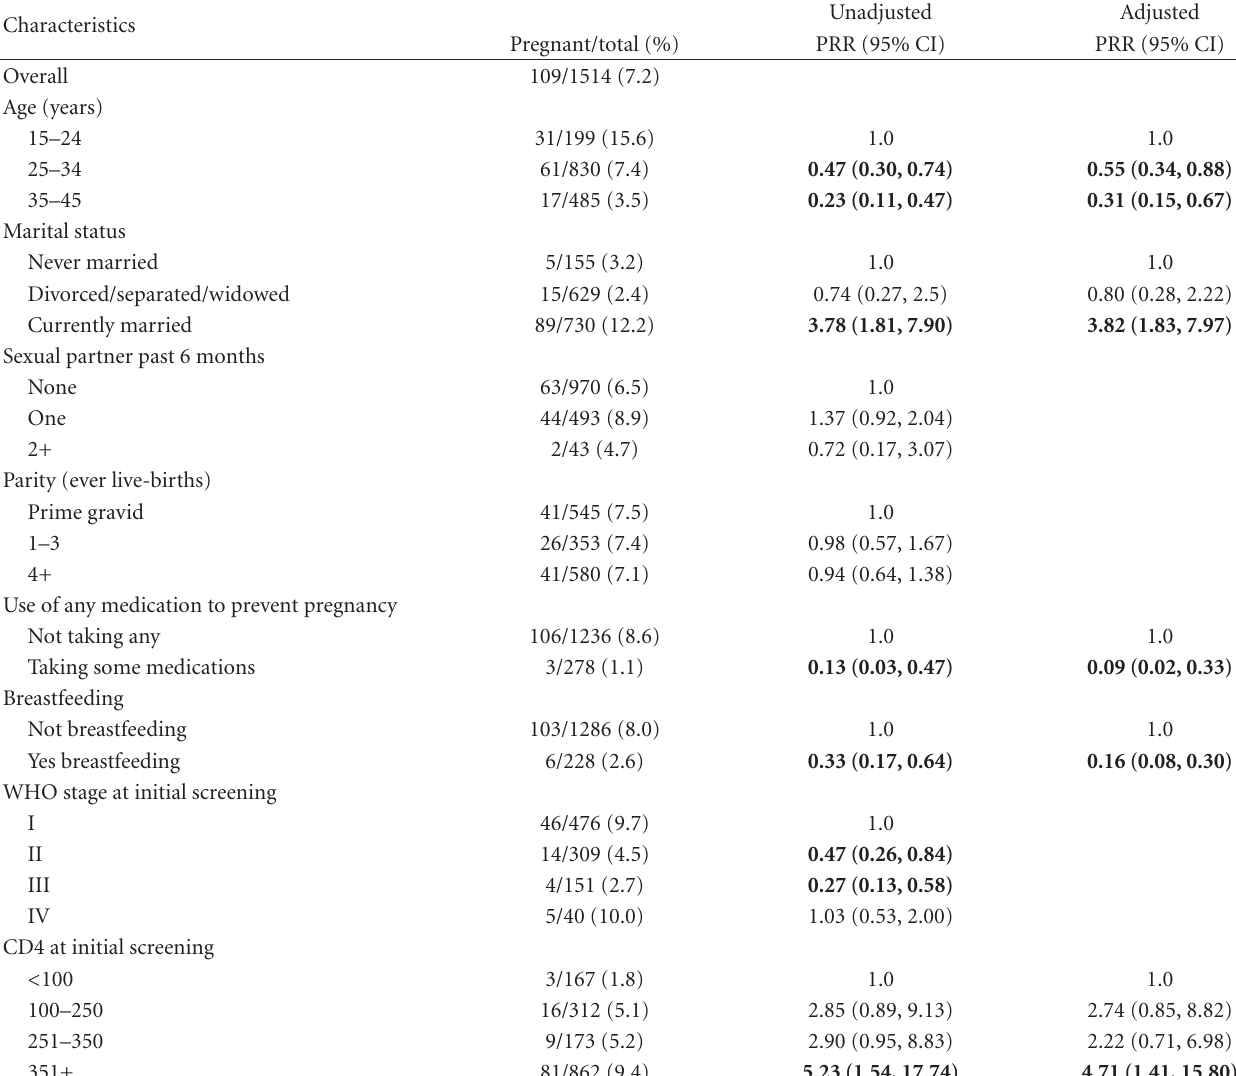
Table 2: Prevalence of pregnancy, unadjusted and adjusted prevalence risk ratios among HIV+ women prior to ART initiation.